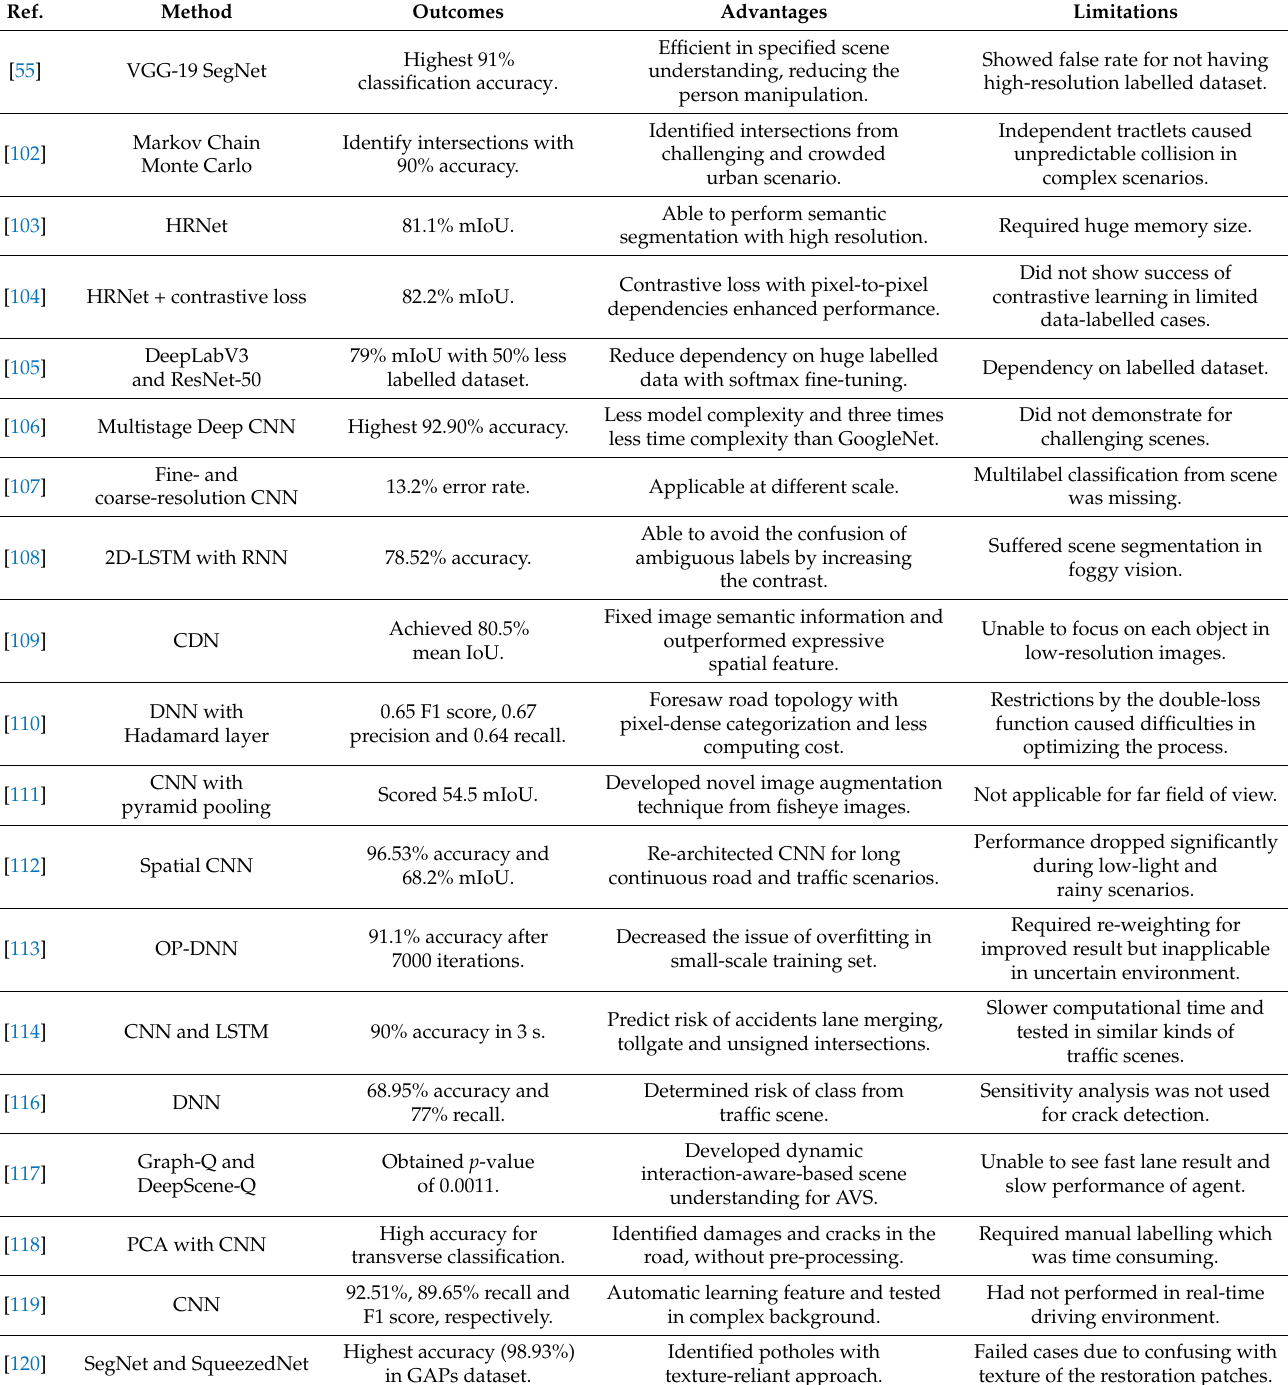
Table 9. Summary of multiple deep learning methods for traffic scene